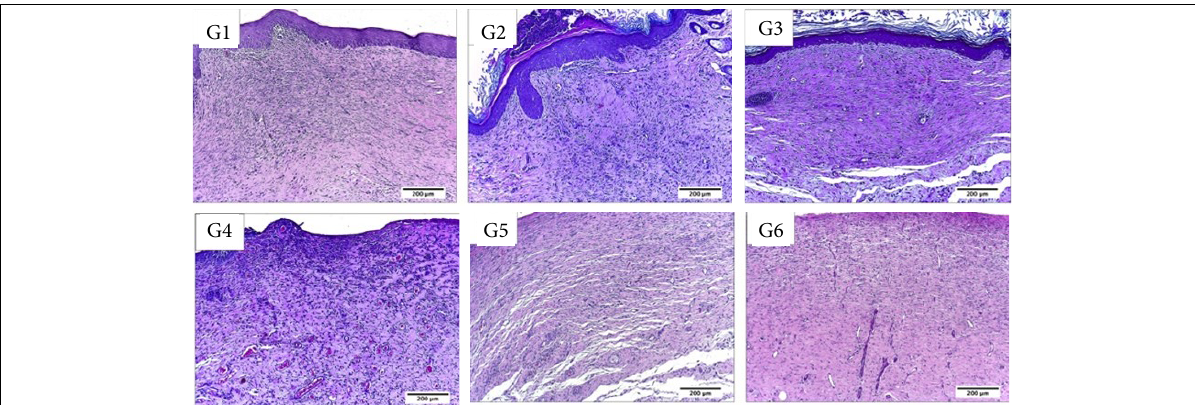
Figure 8 - Microscopic aspects of partial thickness burn wounds experimentally induced in Wistar rats and treated with silver-based dressings 30 DAI, scale bar = 200 μ